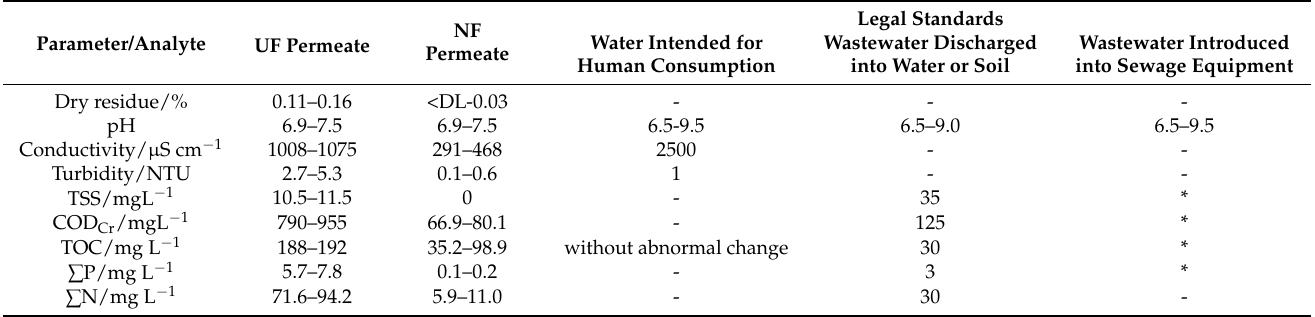
Table 4. Comparison of the physicochemical parameters of the obtained filtrates (after UF and NF of PPW) with the allowed values of these parameters for water intended for human consump- tion, wastewater discharged into water or soil, and wastewater introduced into sewage equipment in Poland.